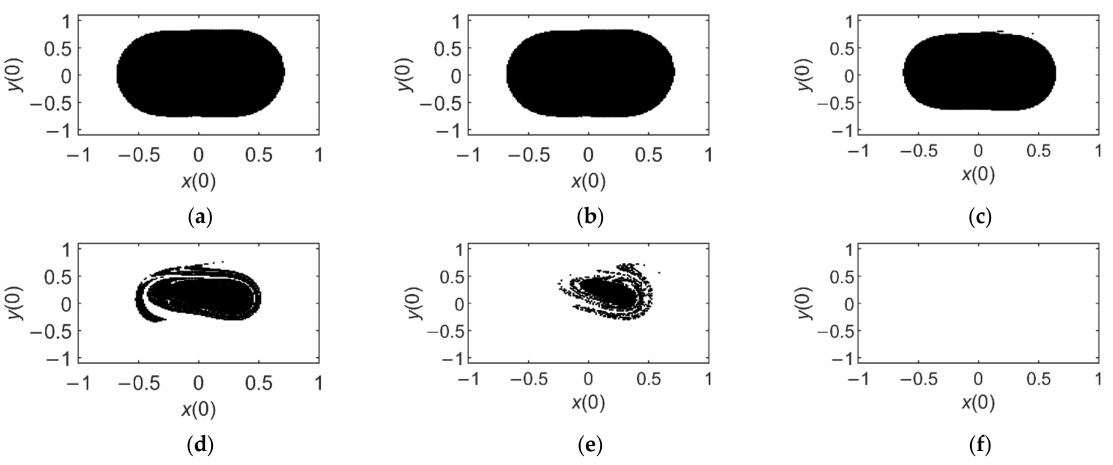
Figure 7. Safe basins of the system (5) under different values of AC voltage amplitude: ( a ) V AC = 0 V; ( b ) V AC = 0.15 V; ( c ) V AC = 0.30 V; ( d ) V AC = 0.50 V; ( e ) V AC = 0.70 V; ( f ) V AC = 1.05